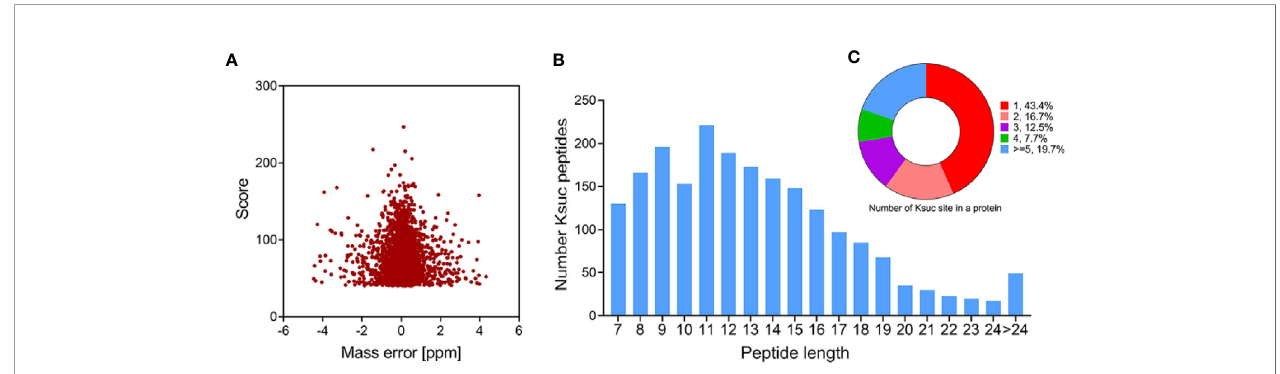
FIGURE 1 | Pro fi le of V. alginolyticus lysine succinylation proteome. (A) Distributions of mass errors for lysine succinylated peptides. (B) Distribution of lysine succinylated peptides based on their length. (C) The pie chart shows the distribution of succinylation sites in each